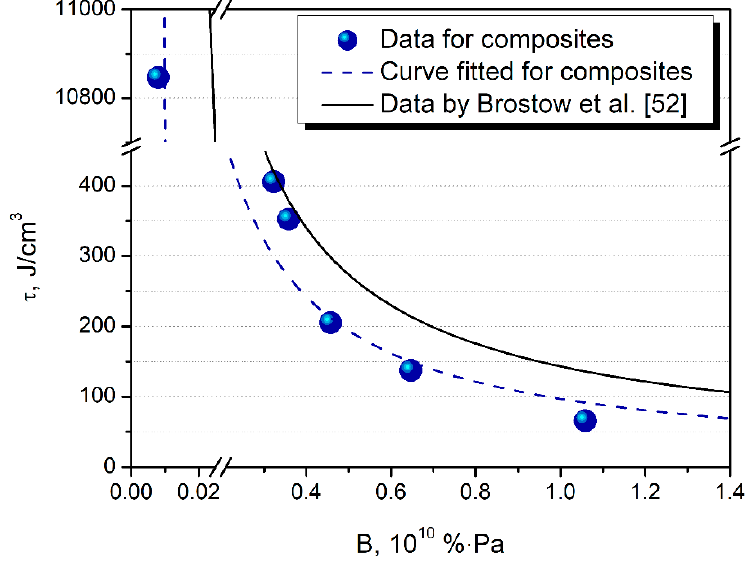
Figure 5. The toughness-brittleness relationship for prepared composites.